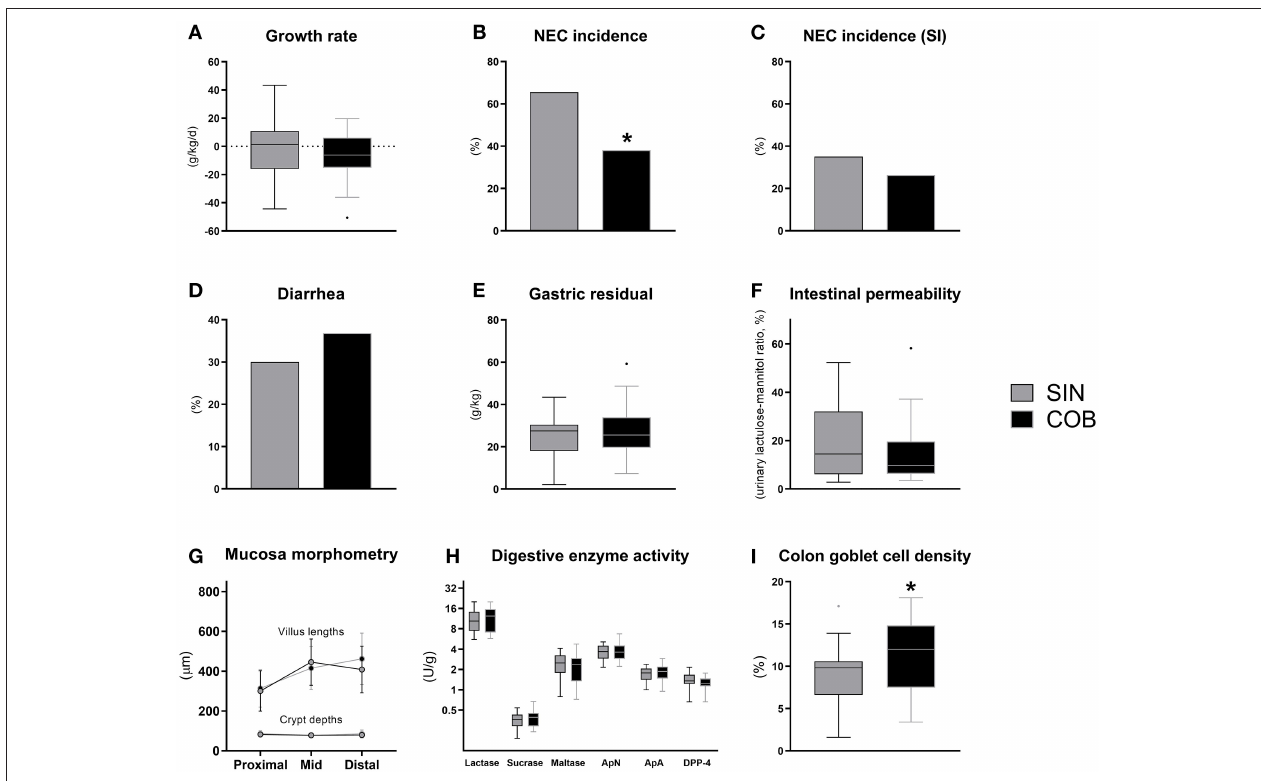
FIGURE 4 | Body growth rate (A) , overall and small intestinal (SI) NEC incidence (B,C) , proportion of pigs with diarrhea (D) , gastric residual volume (E) , urinary lactulose-mannitol ratio as a measure of intestinal permeability (F) , small intestinal villus and crypt morphology (G) , activity of brush-border disaccharidases (lactase, sucrase, maltase) and aminopeptidases (aminopeptidase N, ApN; aminopeptidase A, ApA; dipeptidyl peptidase-4, DPP-4) (H) , and relative area of colonic goblet cells (I) . Dichotomous data is reported as frequencies. Longitudinal data is presented as means with standard deviations, while remaining continuous data is presented as box plots (box edges denote interquartile ranges and horizontal line denotes the median value) with Tukey whiskers (outliers shown as dots). *Denotes a probability value below 0.05. SIN, single-housing; COB, co-bedding. relative to single-housed littermates ( p < 0.05, Figure 4B